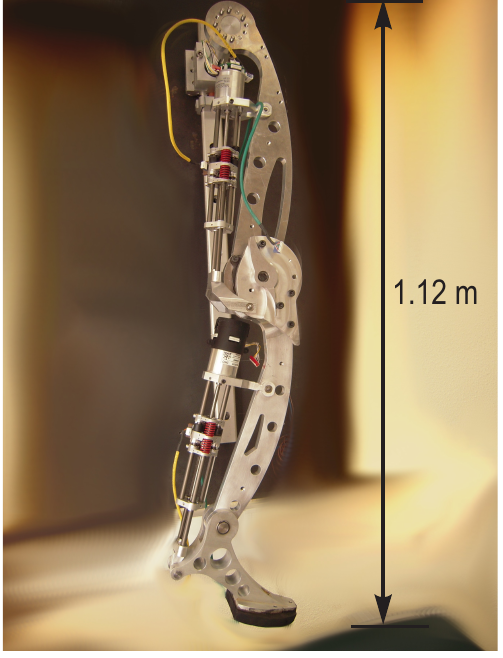
Figure 11. First prototype of the HADE Leg resembling a horse leg.